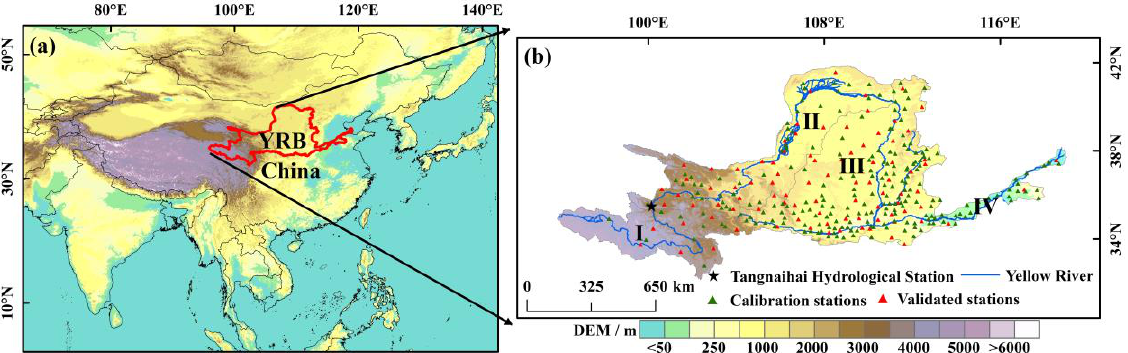
Figure 1. ( a ) The geographical location of the Yellow River Basin in China; ( b ) digital elevation model, and distribution of hydrometeorological stations in the Yellow River basin. Region I is the source region of the YRB (SRYR), region II is the upstream of the YRB (UYRB), III is the midstream of the YRB (MYRB), IV is the downstream of YRB (DYRB).